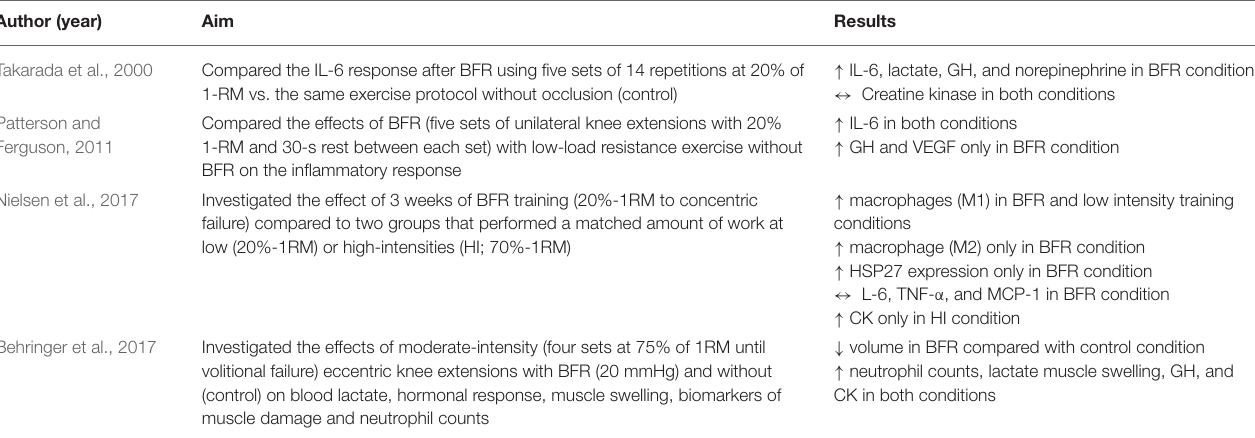
TABLE 1 | Effect of blood flow restriction plus low-intensity strength training on the inflammatory